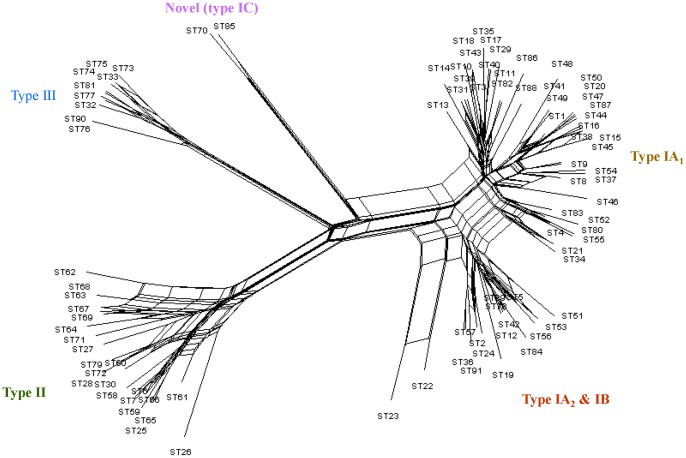
Neighbour-net splits graph of allelic profiles from all 91 P. acnes eSTs.Parallelogram structures indicative of recombination are clearly present within the major divisions I, II and III. Overall levels of recombination within the population were statistically significant (phi test; p = 0.021).